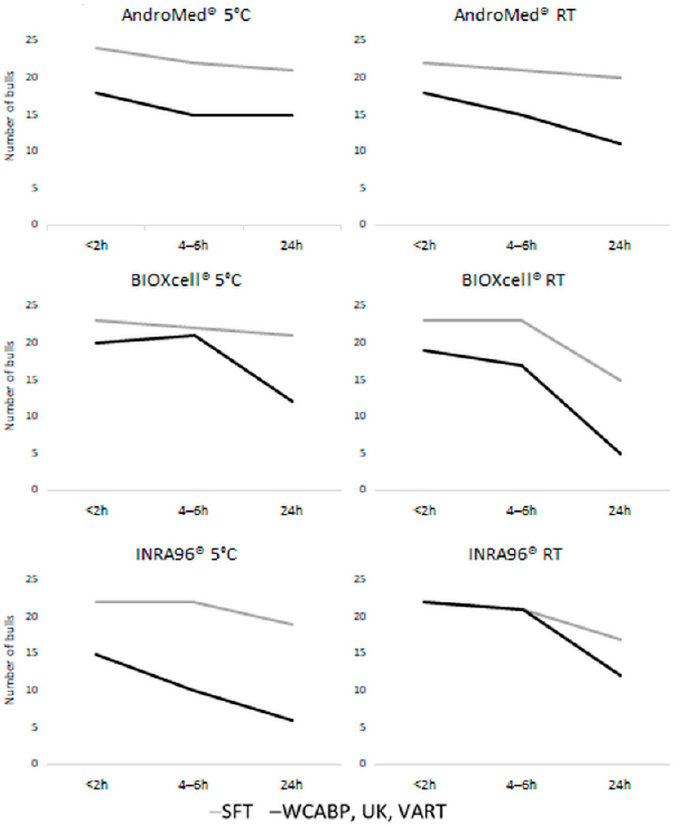
Figure 4. Number of bulls qualified as “suitable” according to different bull breeding soundness evaluation (BBSE) methods. SFT, Society For Theriogenology; UK; VART, Spanish guidelines “Val- oraci ó n de la Aptitud Reproductiva de Sementales” (“Evaluation of Bull Reproductive Ability”). Abbreviations: A: AndroMed ® ; B: BIOXcell ® ; I: INRA96 ® ; RT: room temperature; 5: refrigeration at 5 ◦